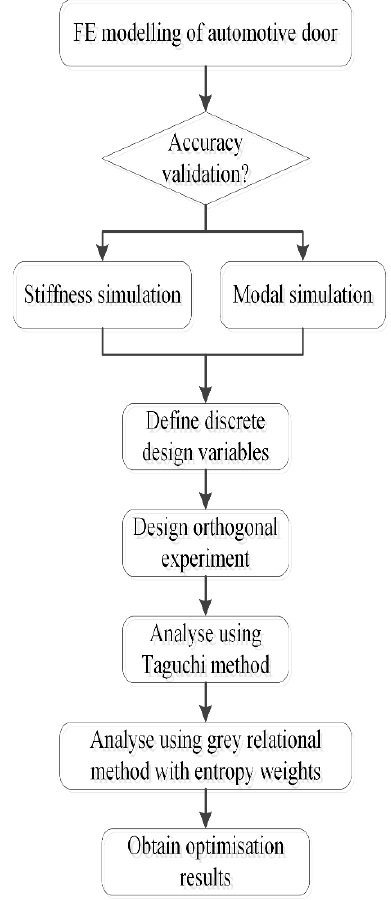
Figure 1. Flowchart of the lightweight optimisation method.